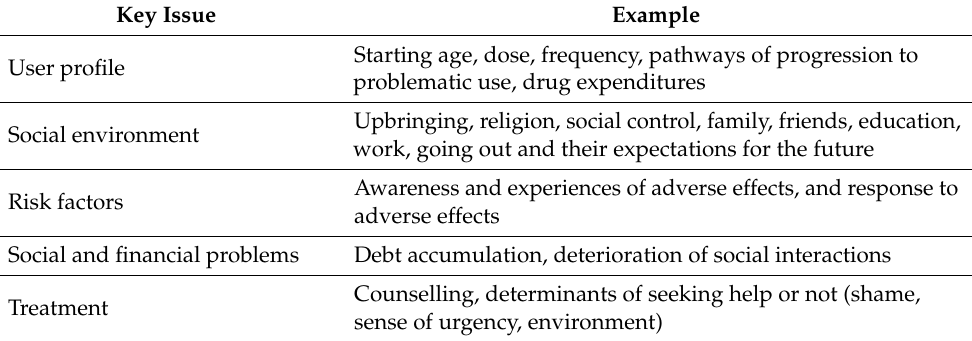
Table 1. List of topics